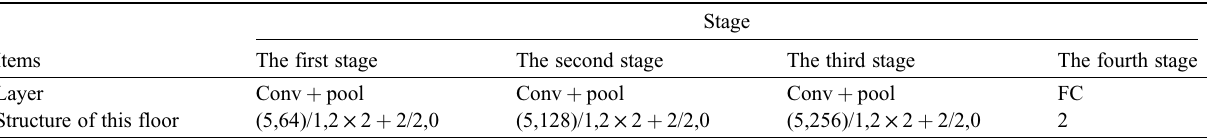
Structure of LeNets þþ deep learning